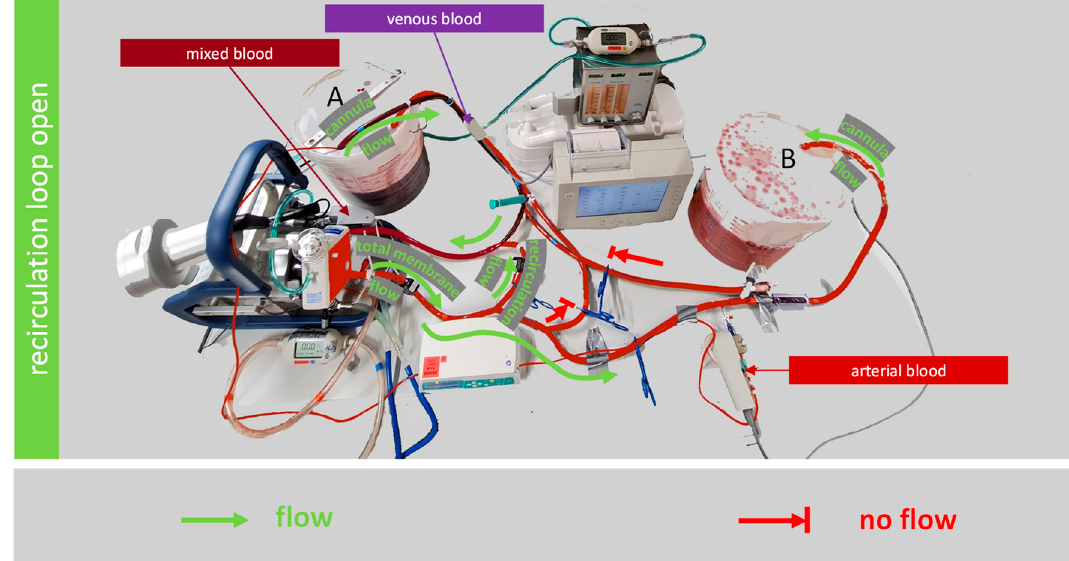
Figure 3. Test setup to measure the effect of a recirculation loop on the oxygen transfer rate of the membrane lung. Both schematic illustrations show the mock circuit during the measuring sequence. In the upper illustration, the recirculation loop is closed. The membrane lung has venous blood as input. In the lower illustration, the recirculation loop is open and transfers arterial blood that already passed the membrane lung back to the inlet of the pump. The membrane lung has mixed blood as input. In both setups, the oxygen transfer rate of the membrane lungs is calculated from the cannula blood flow, the hemoglobin value, the venous saturation (bucket A), and the arterial oxygen pres- sure (bucket B).